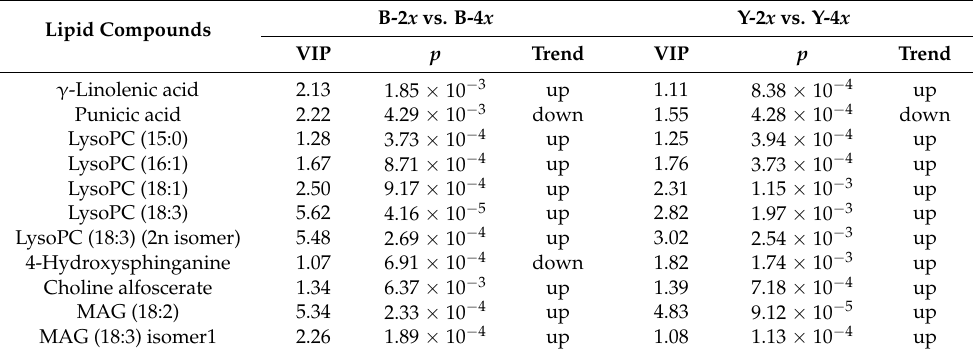
Figure 5. Pathway analysis of lipid metabolites for diploid vs. tetraploid groups and determination of free fatty acids in brown rice. ( A ) Functional annotation and KEGG classification of lipid metabolites. The ordinate is the name of the KEGG metabolic pathway, the abscissa is the number of metabolites annotated to the pathway and its proportion in the total number of lipid metabolites annotated. The proportions of “Biosynthesis of unsaturated fatty acids” and “Metabolic pathways” were both 18% (green background). In addition, the proportion of “alpha-Linolenic acid metabolism” was 4.55% (yellow background). ( B ) Determination of free fatty acids in diploid (2X, yellow) and tetraploid (4X, white) brown rice. * Significantly different at 0.05 probability level. ** Significantly different at 0.01 probability level. Table 1. Identification of significantly different lipid metabolites in diploid and tetraploid groups based on the criteria of VIP > 1 and p <